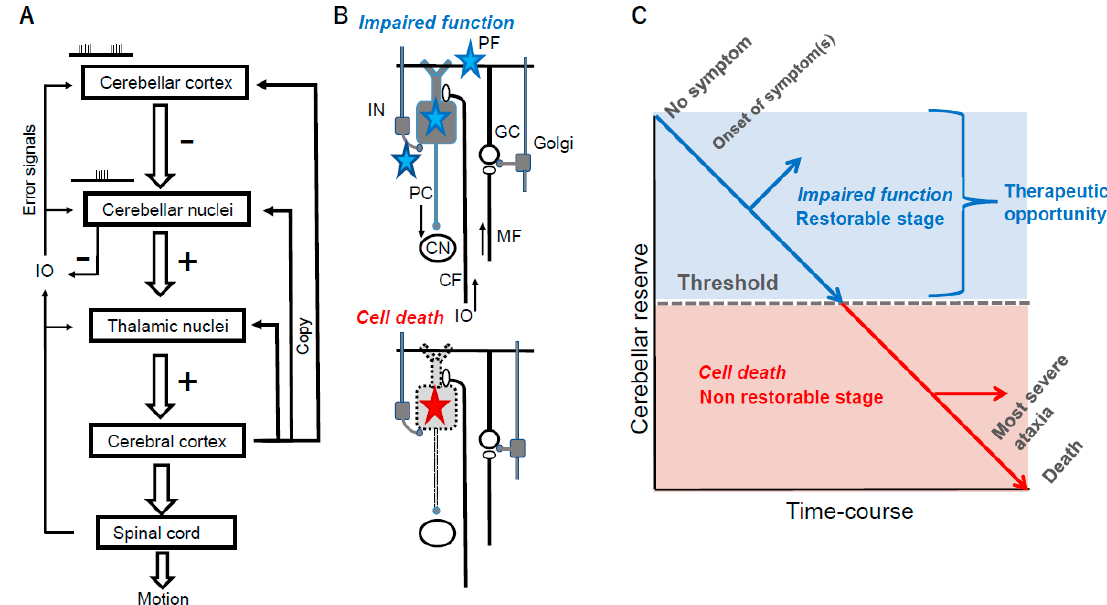
Figure 1. A schematic draw of cerebellar reserve. ( A ) Cerebello-cerebral loops involved in expectations and estimates of future motor/cognitive states. The cerebellar cortex inhibits (-) cerebellar nuclei via Purkinje cells (PC). Cerebellar nuclei exert and excitatory drive (+) over the thalamic nuclei. Cerebellum computes expected motor/cognitive outcomes, relayed via the cerebello-thalamo-cortical pathway. Cerebral cortex sends a copy of motor/cognitive commands to the cerebellar circuitry. The inferior olive (IO) serves as a comparator signaling errors between the expected outcome and the actual outcome via reafferent informations. The climbing fibers tune the activity of the Purkinje layer. Cerebellum re-build constantly the set of expectations in daily life. ( B , C ) During the initial period, cerebellar reserve is preserved. As cell death advances, cerebellar reserve is lost. PC: Purkinje cell, IN: inhibitory interneurons, Golgi: Golgi cell, GC: granule cell, PF: parallel fiber, MF: mossy fiber, CF: climbing fiber, IO: inferior olive nucleus.